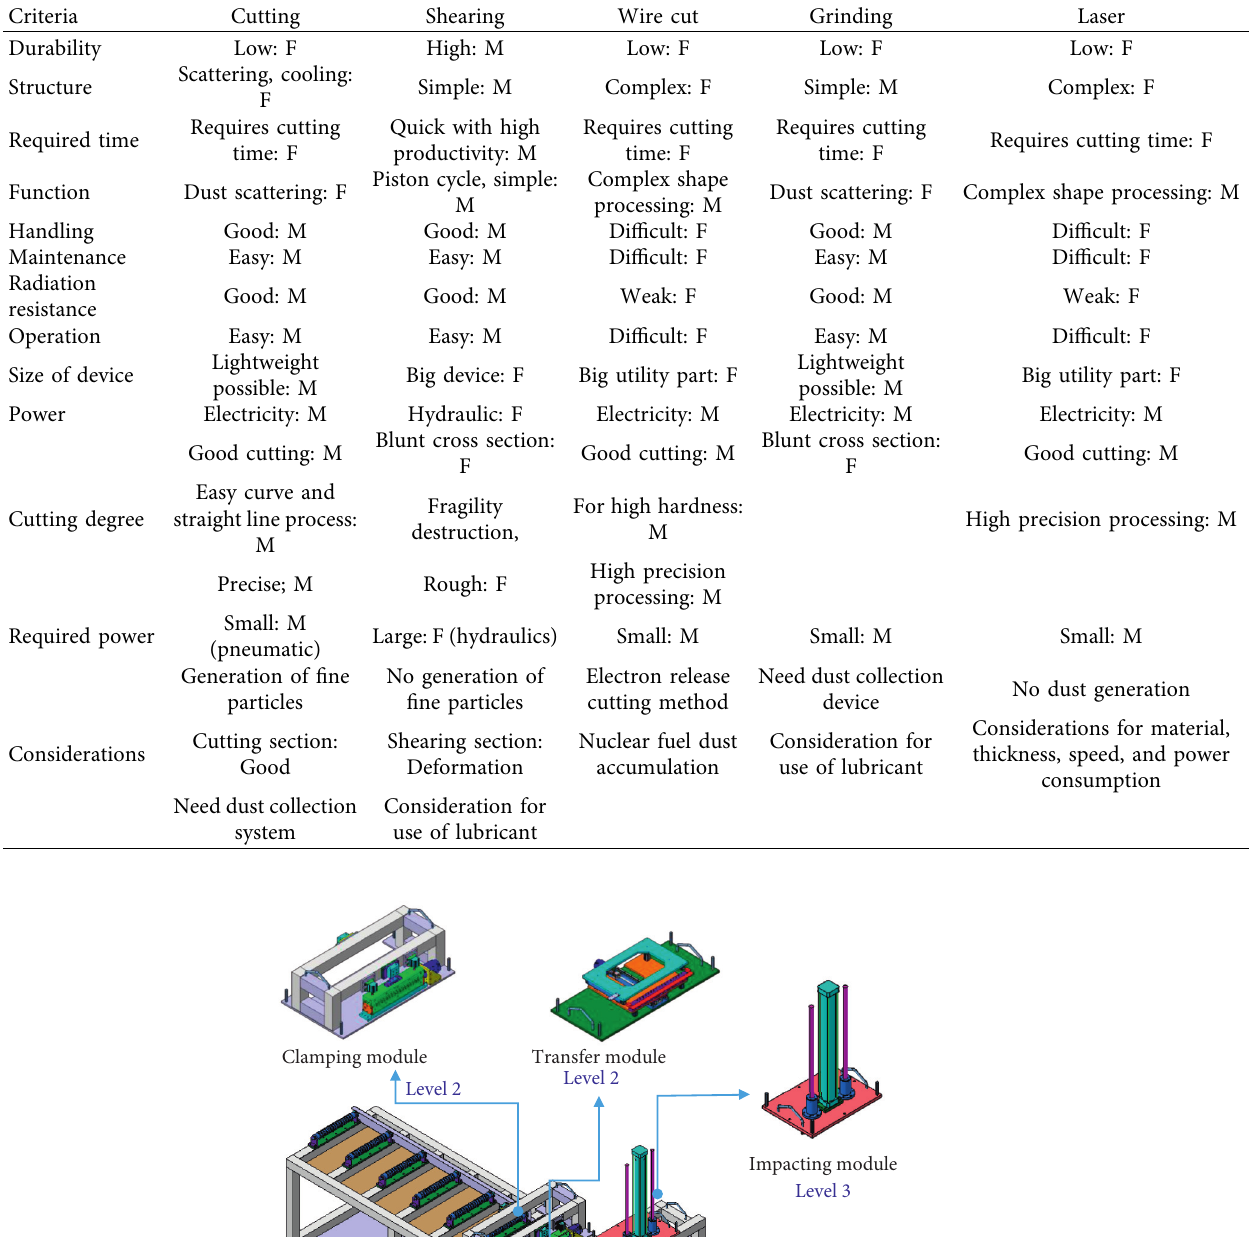
Table 3: Analysis of cutting methods according to various criteria (merits: M, faults: F).